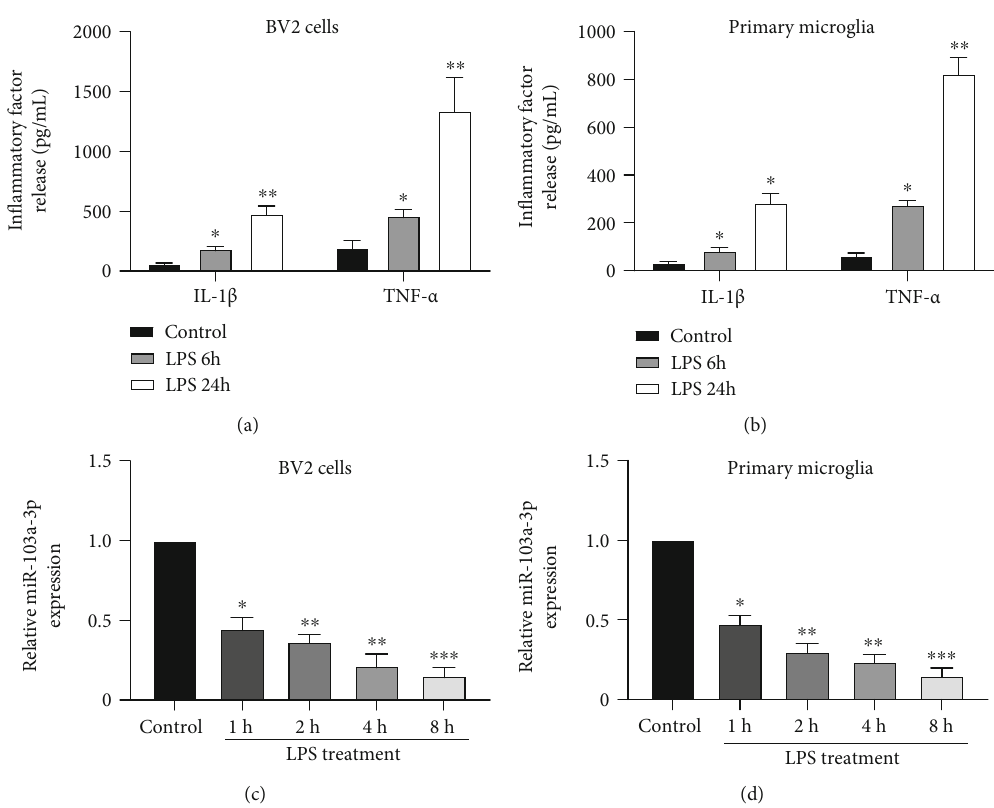
Figure 1: miR-103a-3p is downregulated in LPS-treated BV-2 cells and primary microglial cells. Cultured BV-2 cells (a) and primary microglial cells (b) were treated with 100 ng/ml LPS for 6h or 24h (control, distilled water). The supernatants were collected and subjected to ELISA for the detection of IL-1 β and TNF- α . The expression levels of miR-103a-3p were detected by qRT-PCR from cell lysate of BV-2 cells (c) and primary microglia (d). ANOVA, ∗ p < 0 : 05 , ∗∗ p < 0 : 01 , ∗∗∗ p < 0 : 001 , compared with the control group, n =4 (number of repeated experiments). IL-1 β : interleukin-1 beta; LPS: lipopolysaccharide; TNF- α : tumor necrosis factor